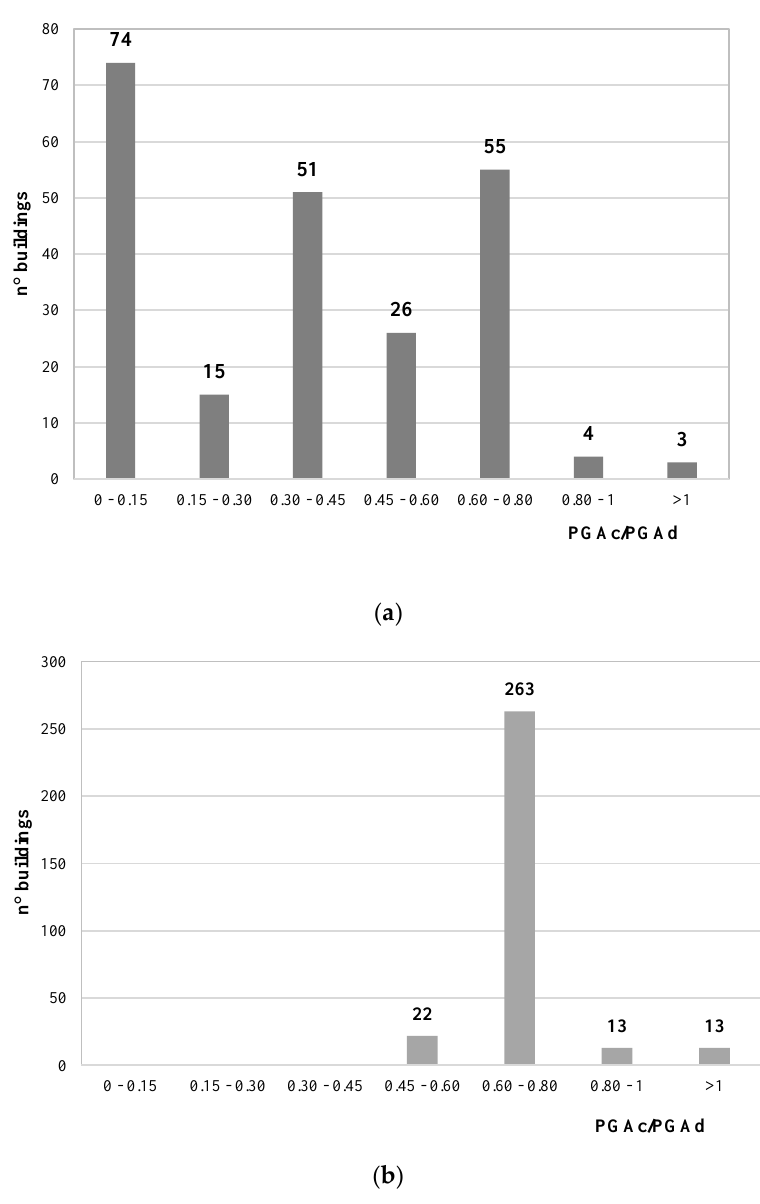
Figure 9. Ratio PGA c /PGA d according to the S&C method for 935 buildings: ( a ) masonry buildings and ( b ) RC buildings.